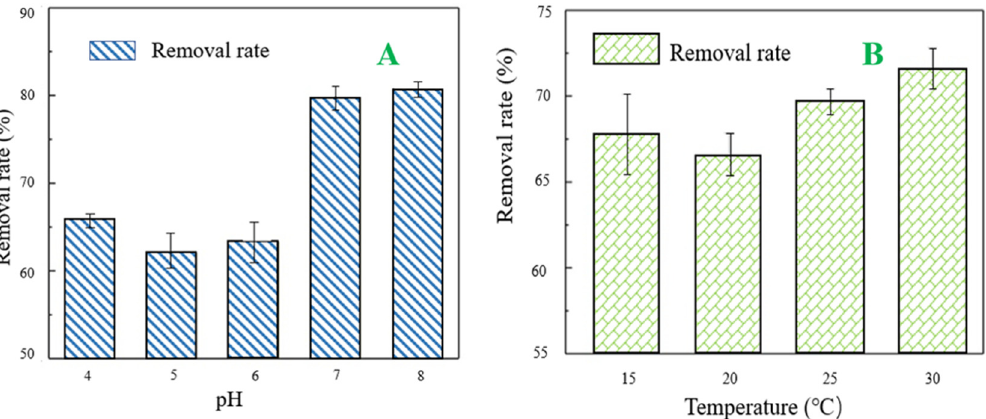
Figure 6. ( A ) phosphate removal at different pH; ( B ) phosphate removal at different temperature.